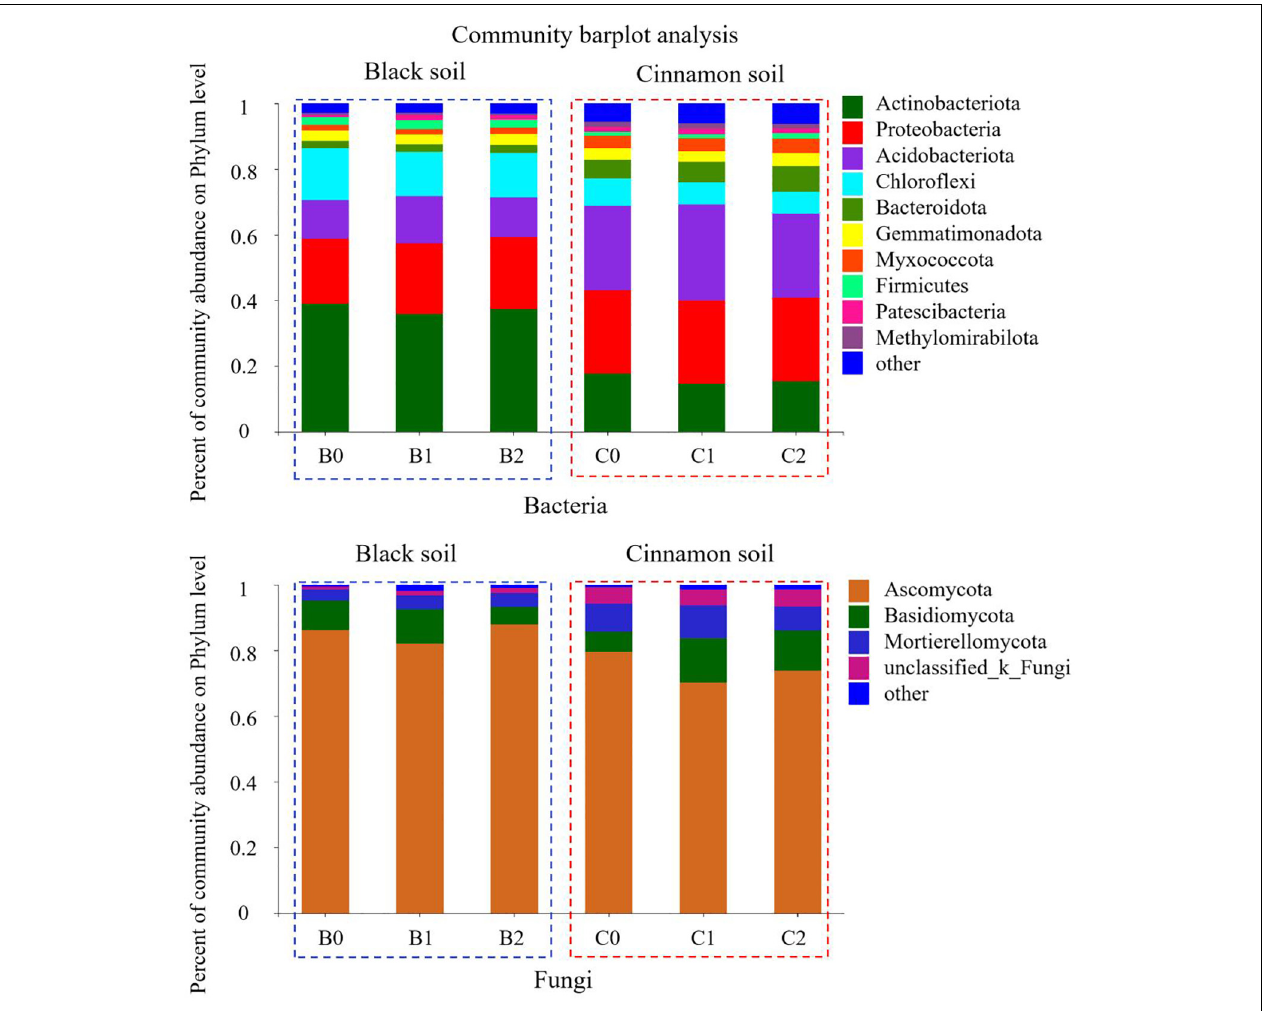
FIGURE 2 | The relative abundance of top 10 phyla for each three treatments in black and cinnamon